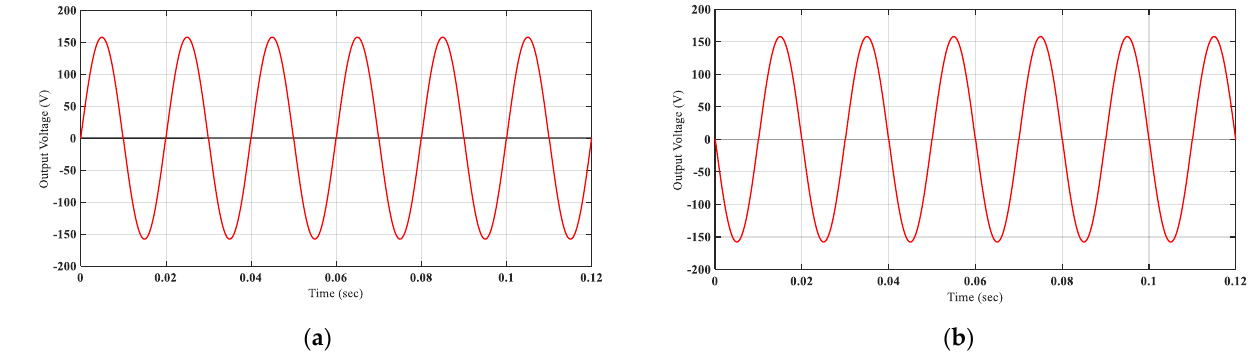
Figure 11. Constant frequency (50 Hz) outputs during: ( a ) non-inverting state; ( b ) inverting state.